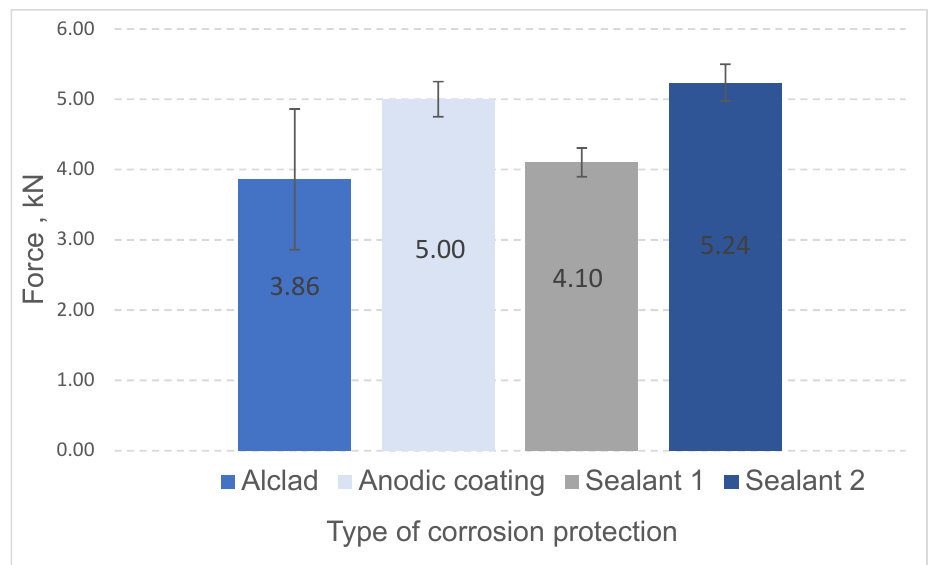
Figure 11. Static strength test results for RSW joints. Materials 2020 , 13 , x FOR PEER REVIEW